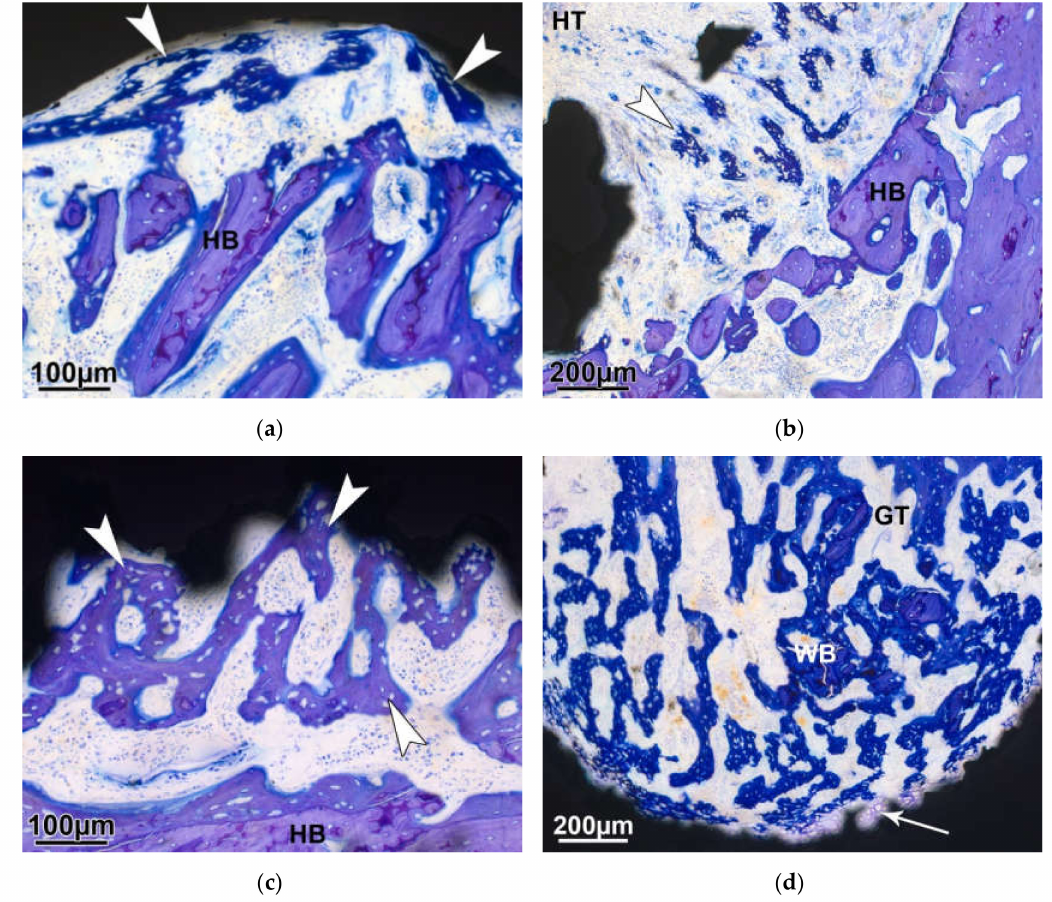
Figure 6. Newly formed woven bone (arrowhead) is visible on the outside of the implant ( a : 7days and c : 14 days). ( b ) At 7 days, woven bone (arrowhead) starts growing through the openings of the implant towards the inside. ( d ) After 14 days, the cavity is largely filled with newly formed trabeculae, which sometimes develop through enchondral ossification (arrow). Coated implant; HB—host bone; WB—woven bone; HT—hematoma residues; and GT—granulation